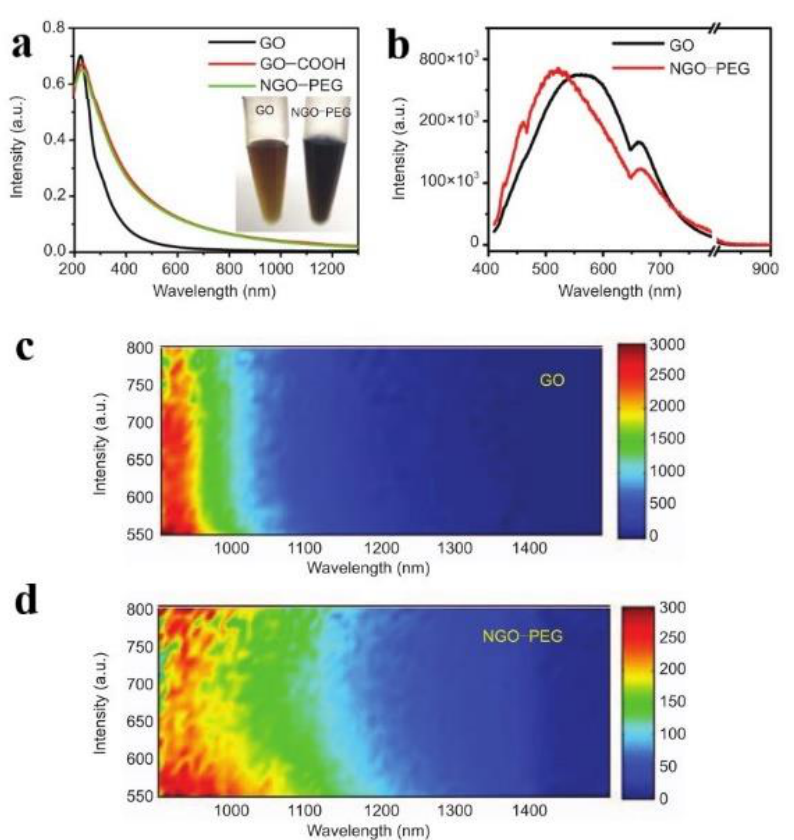
Figure 2. ( a ) Absorption spectra of GO, GO-COOH, and NGO-PEG solutions. ( b ) The fluorescence of GO and NGO-PEG in the visible region. ( c , d ) PL spectra of GO and NGO-PEG in the infrared region. Reprinted with permission from [17]. Copyright 2008, Springer Nature.